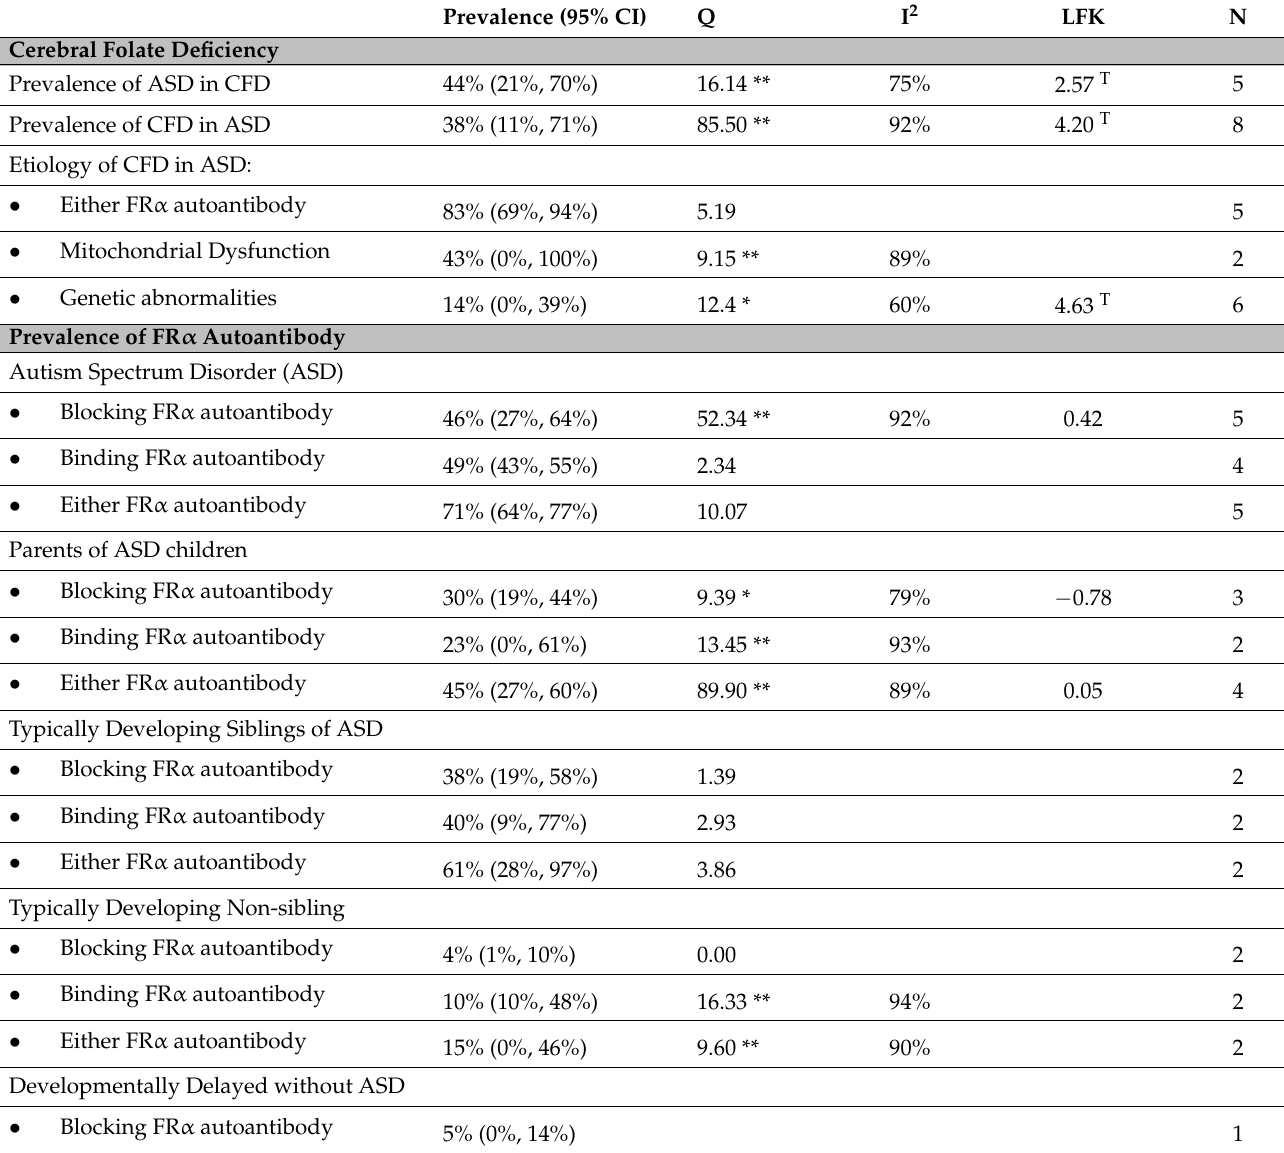
Table 1. Meta-analysis results for the prevalence of cerebral folate deficiency and folate receptor alpha autoantibodies. Pooled prevalence with 95% confidence interval, Cochran’s Q (Q), Heterogeneity Index (I 2 ), Luis Furuya-Kanamori (LFK) Index and number of studies involved (N). Statistics are estimated by a random-effects model. * p < 0.05; ** p < 0.01; T Significant